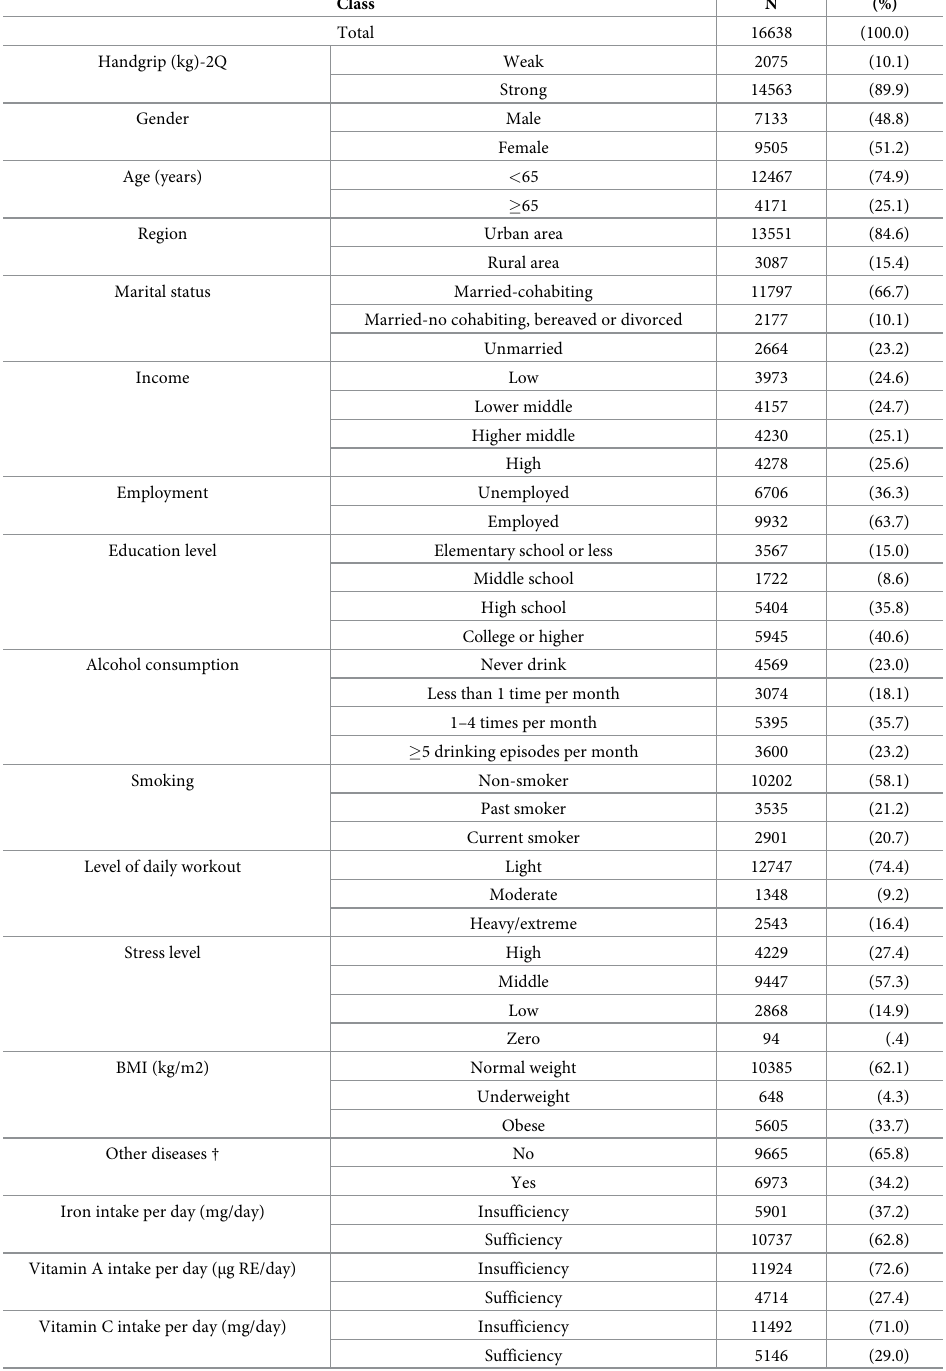
Table 1. Description of the basic characteristics of the study